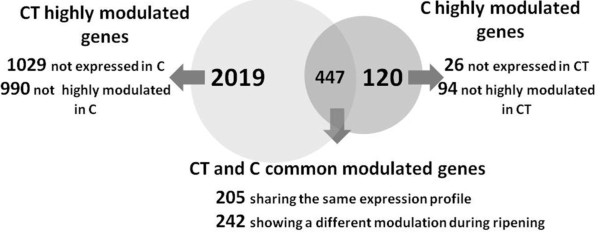
Differentially expressed genes during ripening in CT and C berries. Transcripts are divided into three different gene datasets according to their high modulation in CT, in C or in both. The number of CT highly modulated genes either not expressed in control berries or expressed but not highly modulated is shown. Similarly the number of C highly modulated genes either not highly expressed in CT berries or expressed but not highly modulated is shown. The number of common modulated transcripts with equal or different modulation is specified.